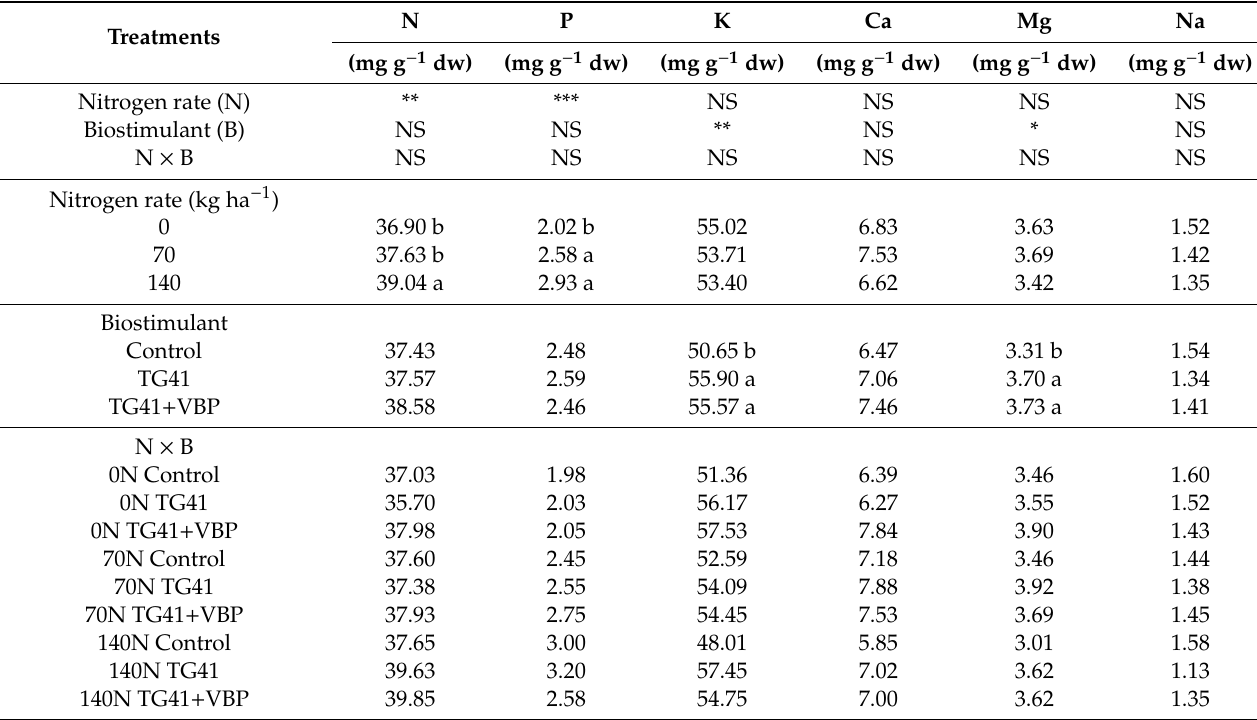
Table 3. Total nitrogen (N), phosphorus (P), potassium (K), calcium (Ca), magnesium (Mg), and sodium (Na) concentrations of greenhouse Romaine lettuce plants